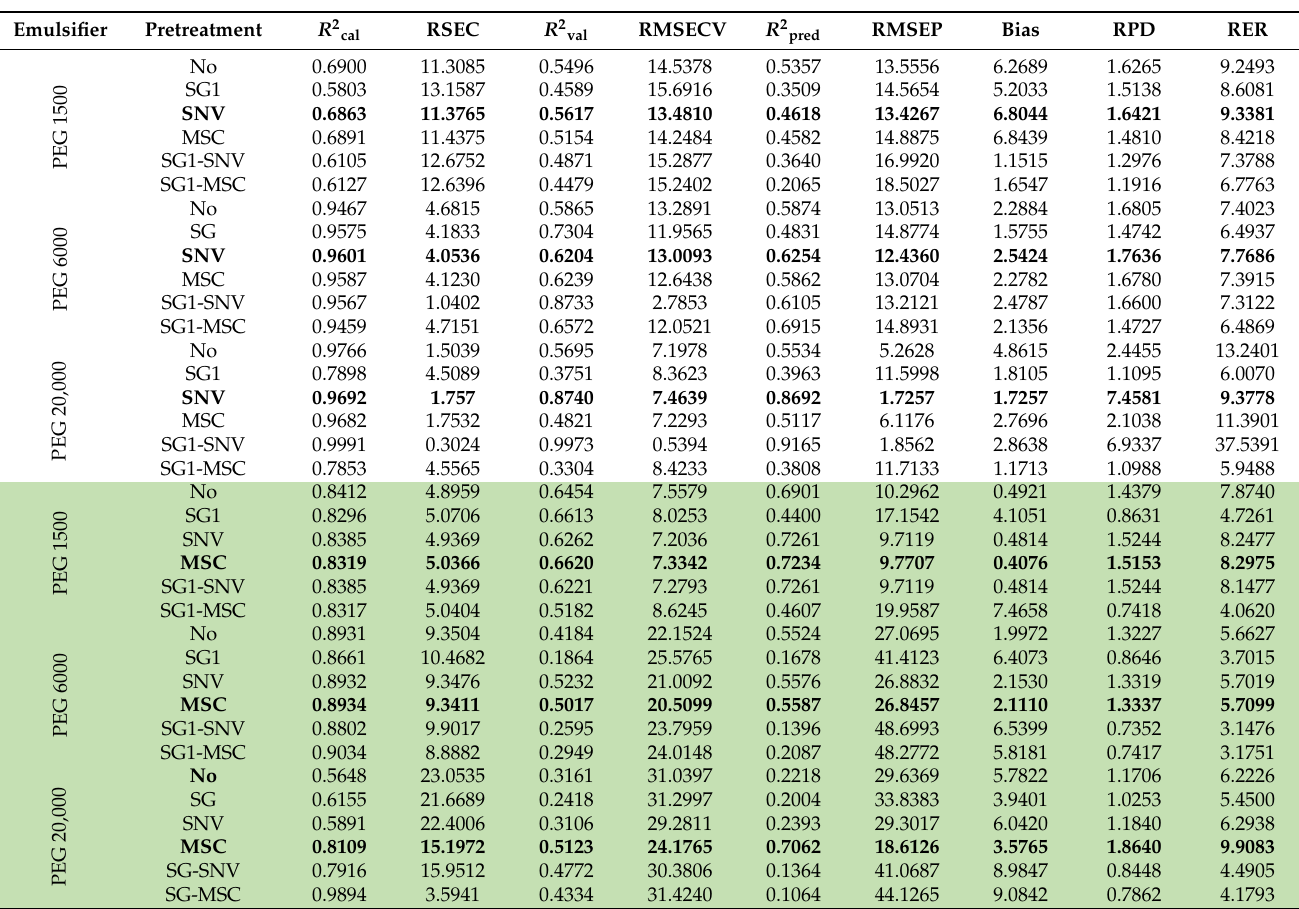
Table 2. Parameters of partial least-squares (PLS) models for the prediction of the average droplet size, expressed as the average Feret diameter of oil-in-water emulsions and oil-in-aqueous mint extract (green shading) emulsions prepared in a microfluidic device at different flow rates using different emulsifiers based on different NIR spectra pretreatments. Preprocessing methods: raw spectra (No), first-order Savitzky–Golay derivative (SG1), standard normal variate (SNV), multiplica- tive scatter corrections (MSC), first-order Savitzky–Golay derivative followed by standard normal variate (SG1+SNV), and first-order Savitzky–Golay derivative followed by multiplicative scatter corrections (SG1+MSC). Model applicability: the coefficients of determination for calibration ( R 2 cal ) and cross-validation ( R 2 cval ), the root-mean-square error for calibration (RMSEC) and cross-validation (RMSECV), the average value of the difference between the predicted and observed values (bias), the ratio of predicted deviation (RPD), and the range error ratio (RER). Seven factors were included in each